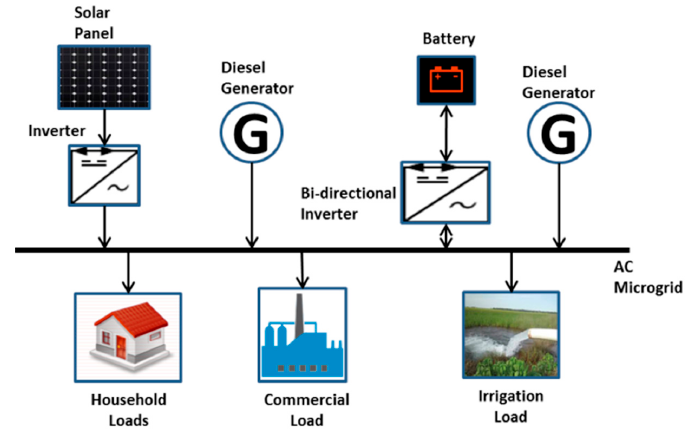
Figure 2. Renewable energy integrated islanded microgrid.